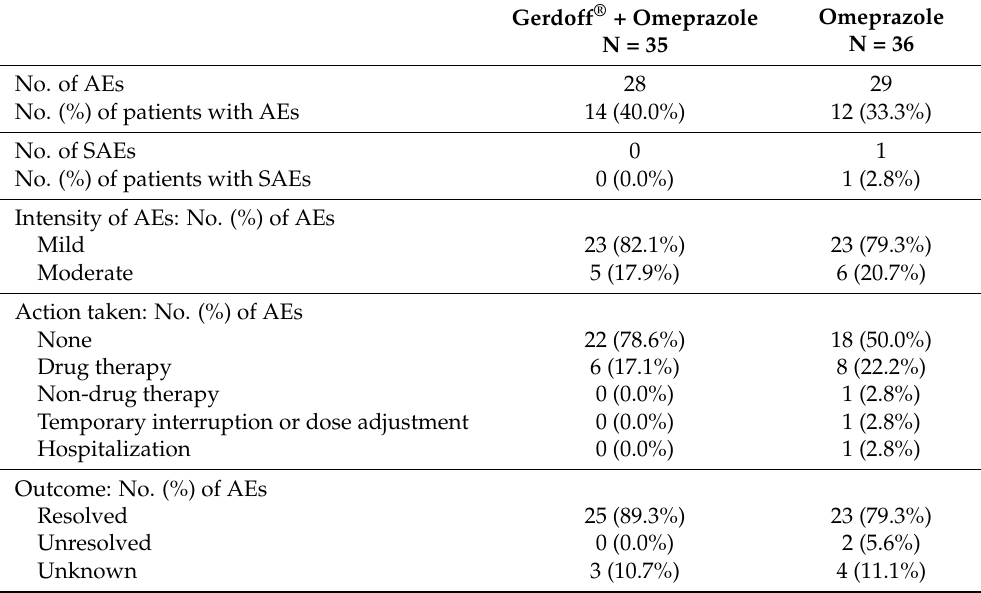
Table 8. Summary of adverse events (AEs) in the two